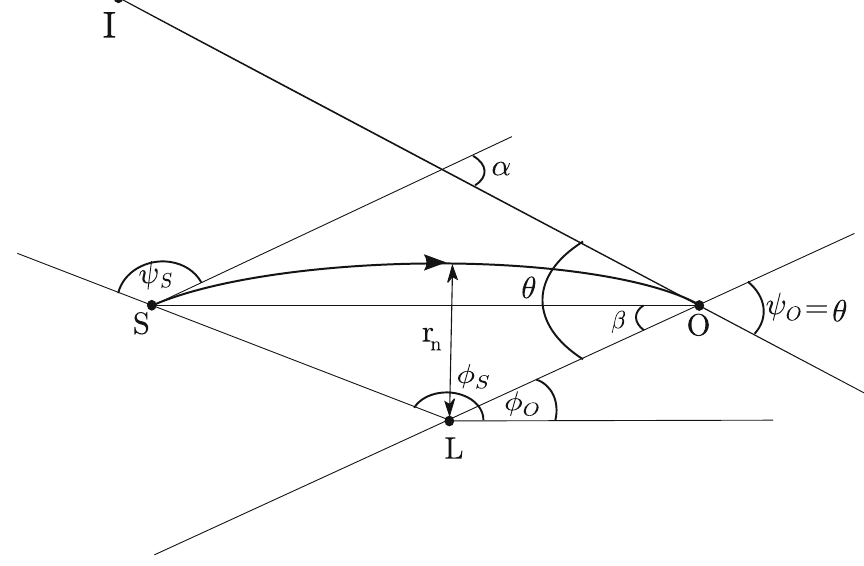
Fig. 5 The symbols I, L, O, and S denote the image, lens ( black hole ), observer, and source, respectively. The angles φ and ψ , r min , and r are those defined in Fig. 4. The angles β and θ are the angular positions of the source and image, and α = (φ − φ ) + (ψ − ψ ) is s o o s the deflection angle. The image location θ is the angle (cid:7) IOL, which is by definition ψ o =